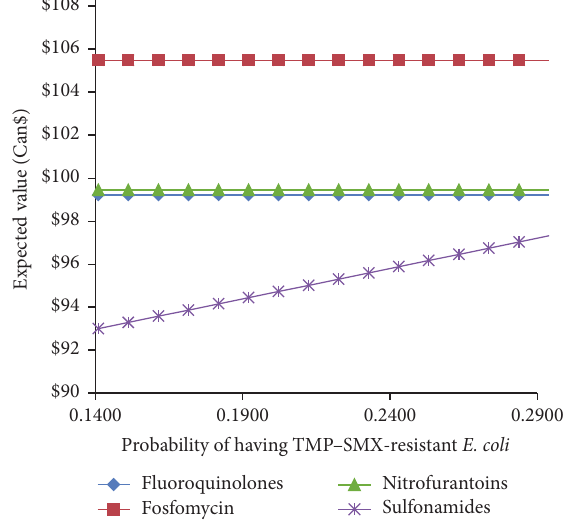
Figure 8: Comparison of the expected value of the cost-per- patient when treating uUTI with fluoroquinolones, sulfonamides, nitrofurantoin,andfosfomycinversustheprobabilityofauUTIwith TMP–SMX-resistant E. coli